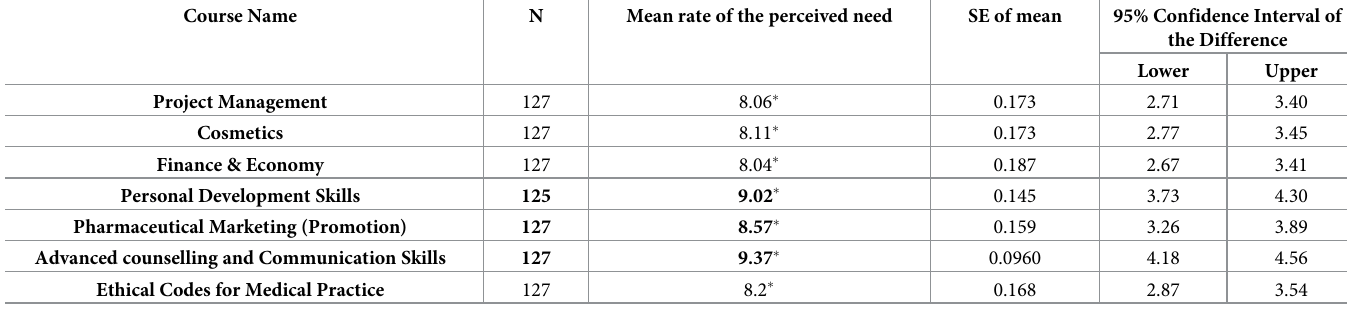
Table 8. Community pharmacists views on courses that should be required for pharmacists to complete.